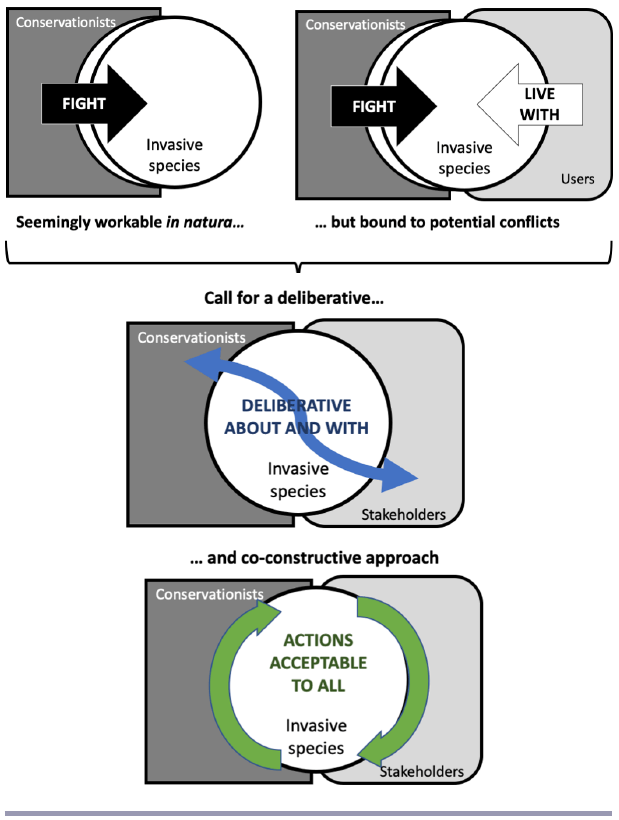
Fig. 1. Conceptual schematization of our two-step approach: from the simplistic approach of academic conservationists (Manage = Fight) to a call for a deliberative co-constructed approach (Manage = Actions acceptable to